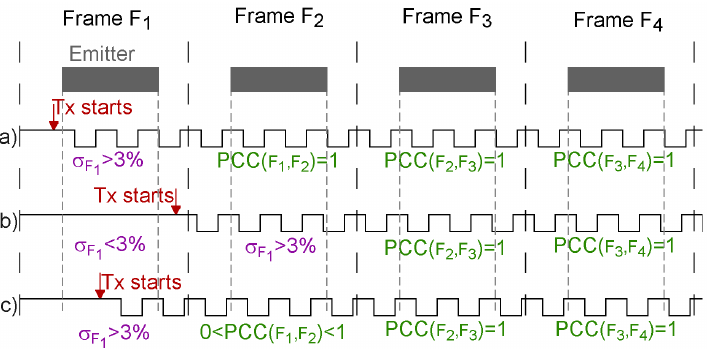
Figure 8. Transmission’s examples. ( a ): the transmission started previous to the emitter’s acquisition; ( b ): the emission began after the projection of the transmitter on the frame; ( c ): the first bit was transmitted during the acquisition of the emitter’s pixel